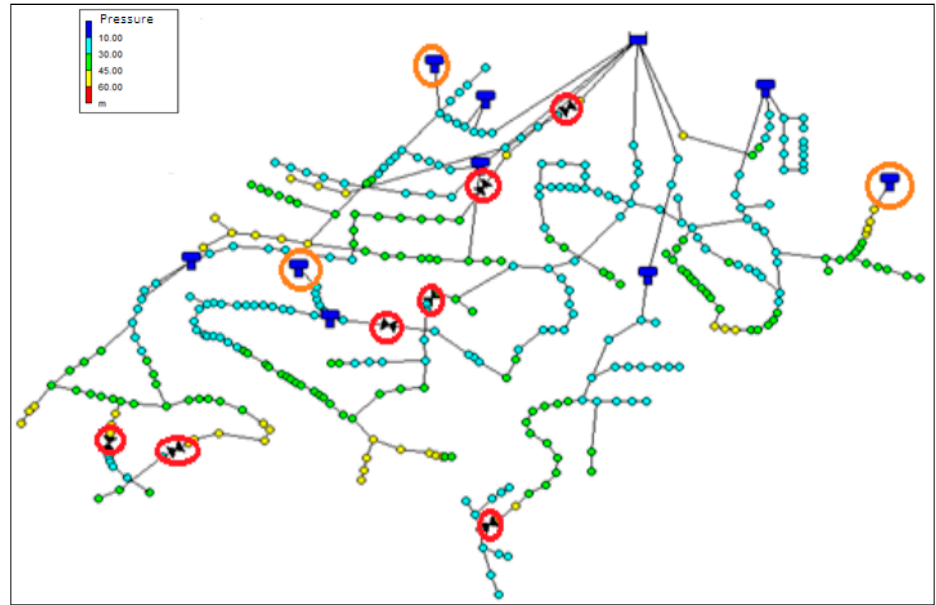
Figure 8. Hydraulic simulation of the best solution.